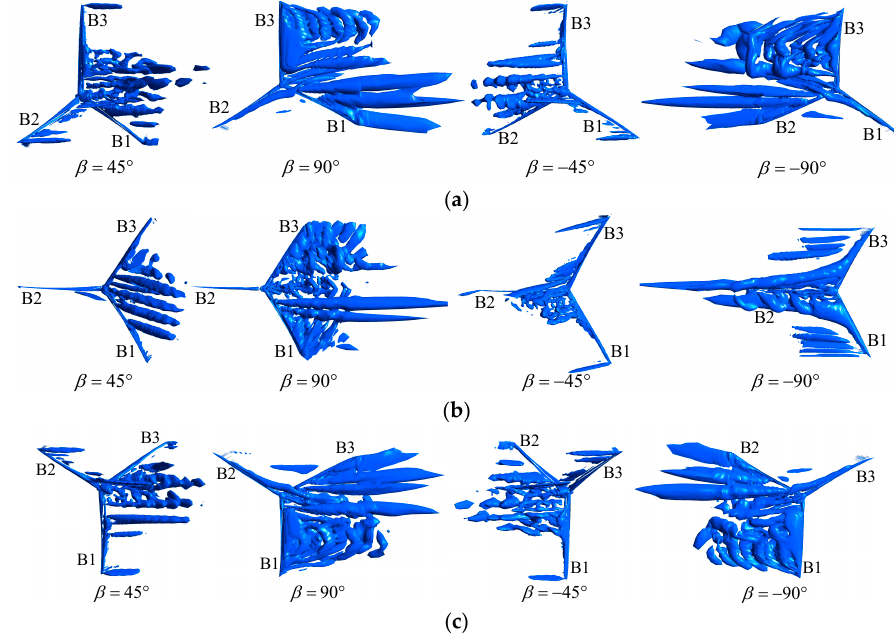
Figure 5. Vortex structure of the wind rotor ( λ 2 = ´ 0.547): ( a ) θ = 0 ˝ parking position; ( b ) θ = 30 ˝ parking position; ( c ) θ = 60 ˝ parking